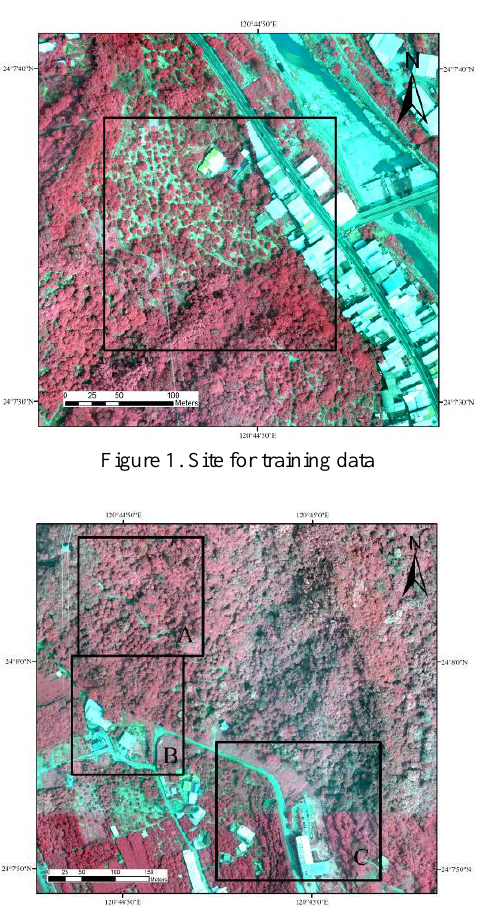
Figure 2. Sites for test